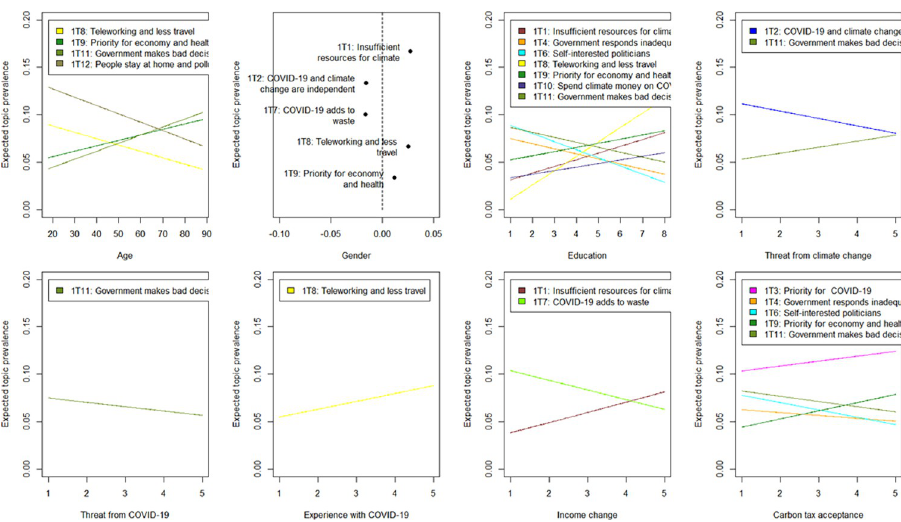
Fig 1. Effect of covariates on topic prevalence for thoughts on governmental climate action. Note: Point estimates of selected covariates on topic prevalence are plotted holding all other covariates constant. The plot for gender shows mean difference in topic proportions between male and female (a positive value on the X-axis indicates a larger prevalence for male respondents). Only results significant at least the 1% level are displayed. Results for all topics are available in S5 Table in S1